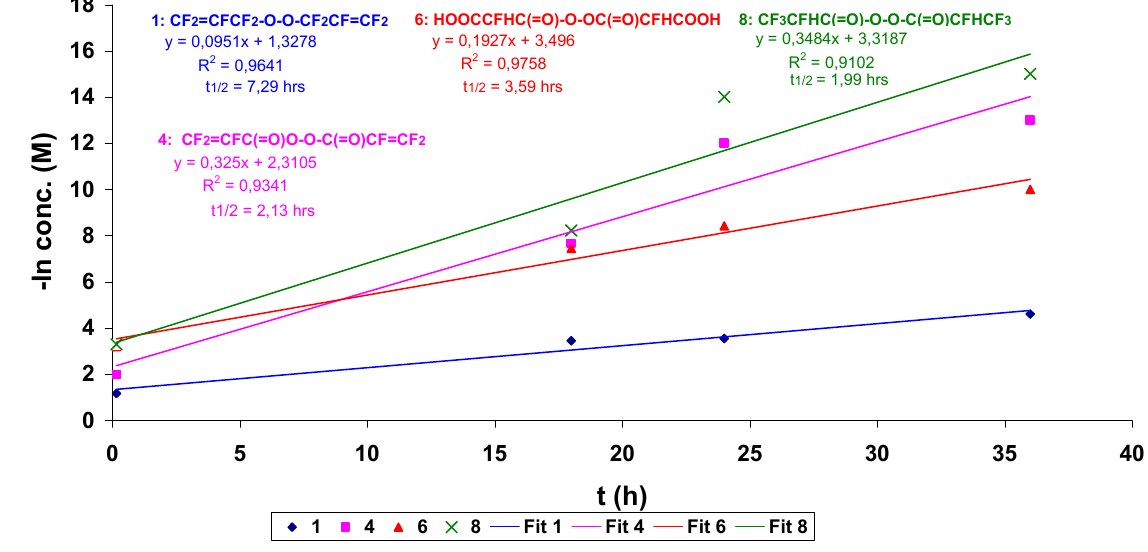
and half-life t at 20 °C for the peroxides observed. d 1/2